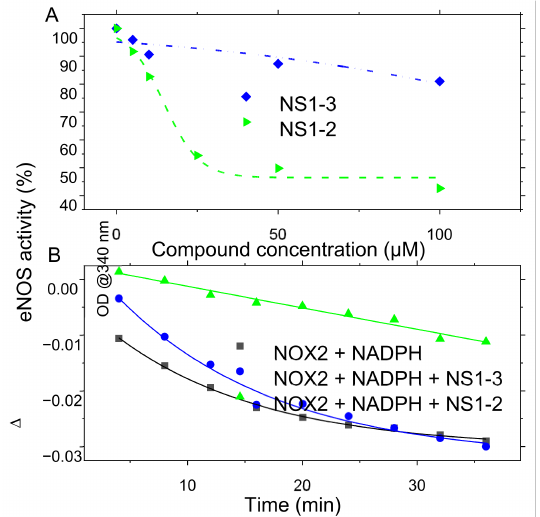
Figure 7. Effect of NS1 and its isomers on ( A ) eNOS activity determined by the hemoglobin assay [19]; ( B ) Representative absorption changes around 340 nm due NOX2-induced NADPH consumption using NOX2 = 2.5 µ M reconstituted with 50 µ M FAD, NADPH = 50 µ M with or without 25 µ M of NS1-2 or NS1-3 in 20 mM Tris buffer pH = 7.5, 150 mM